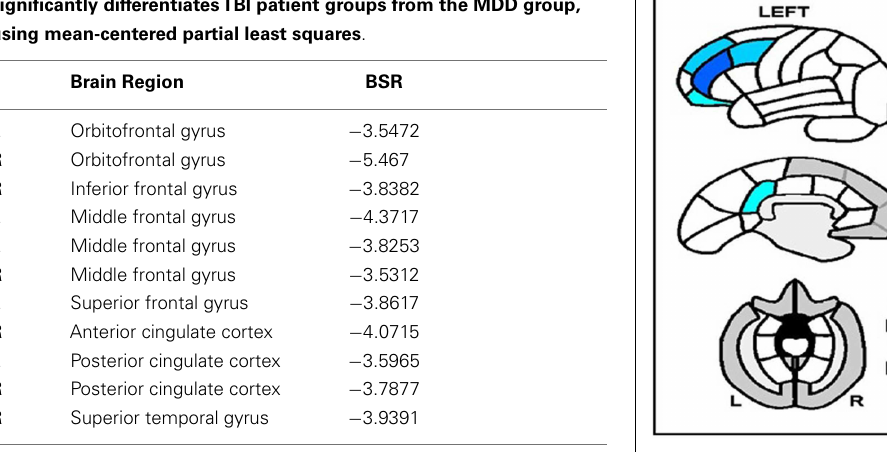
FIGURE 2 | Brain regions significantly differentiating depressed and non-depressedTBI patients from major depressive disorder patients . Regions in blue show lower perfusion levels in depressed patients compared to both mTBI patient